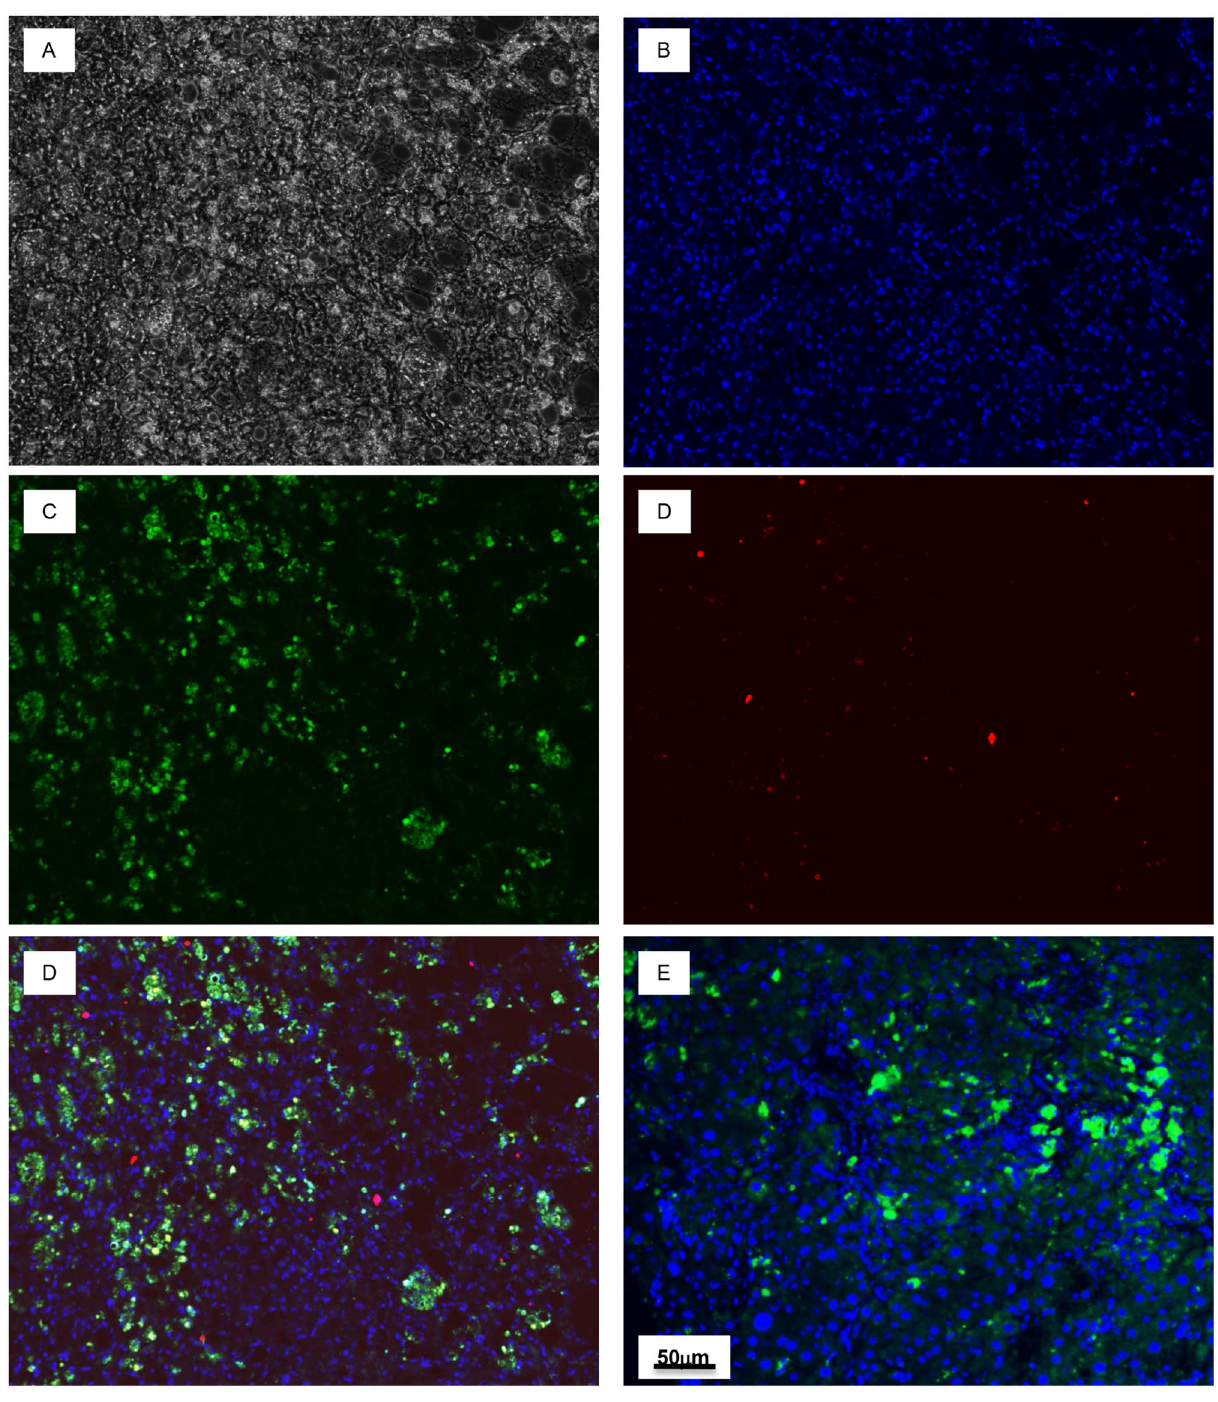
Figure 11. Detection of HBV infection in transgenic MUP-uPA/SCID/Bg mice engrafted with human hepatocytes. A . Bright field image of transgenic mouse liver section. B . DAPI staining of nuclei. C . Stained with anti-hAlb (green). D . Stained with primary anti-HBV (core Ag) antibody (red). E . Merged sections that were stained with both anti-hAlb (green) and anti-HBV (core Ag) primary antibodies (yellow). F . Section from engrafted but not virus inoculated mouse liver stained with anti-hAlb and anti-HBV (core Ag) primary antibodies.